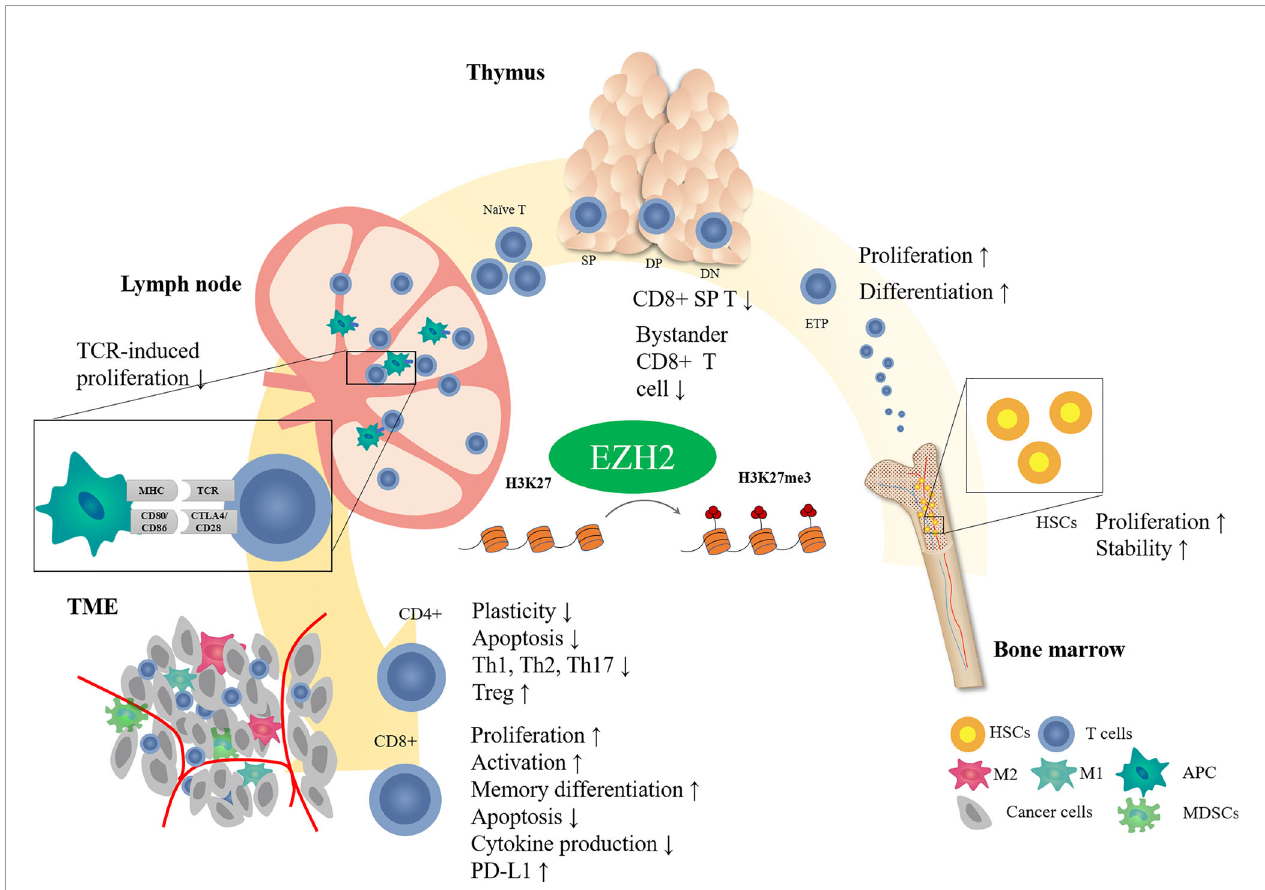
FIGURE 1 | Effect of EZH2 on T cell development. T cells receive antigenic stimulation in lymph nodes after maturation in the thymus and are recruited into the tumor region to exert antitumor effects. EZH2 modi fi es different stages of T cell development through epigenetic regulatory